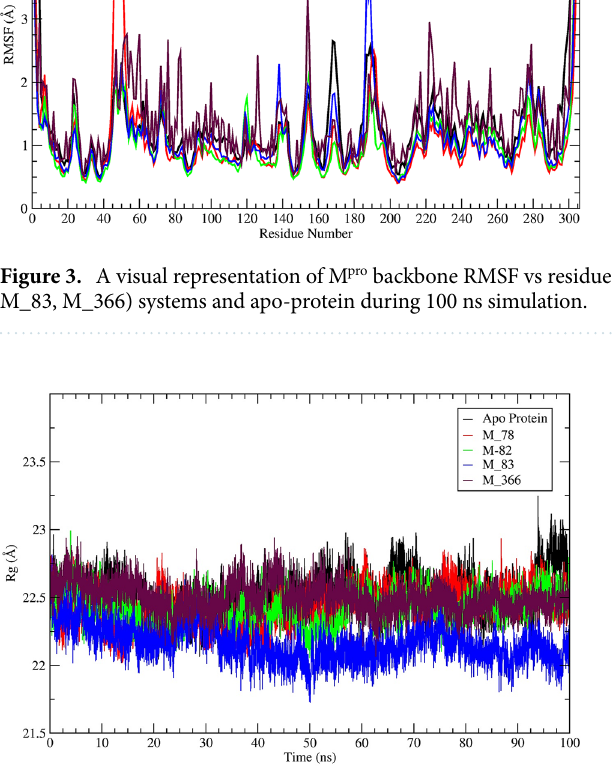
Figure 4. A visual representation of radius of gyration (Rg) vs time of M pro ‒ ligand (M_78, M_82, M_83, M_366) systems and apo-protein during 100 ns MD simulation.